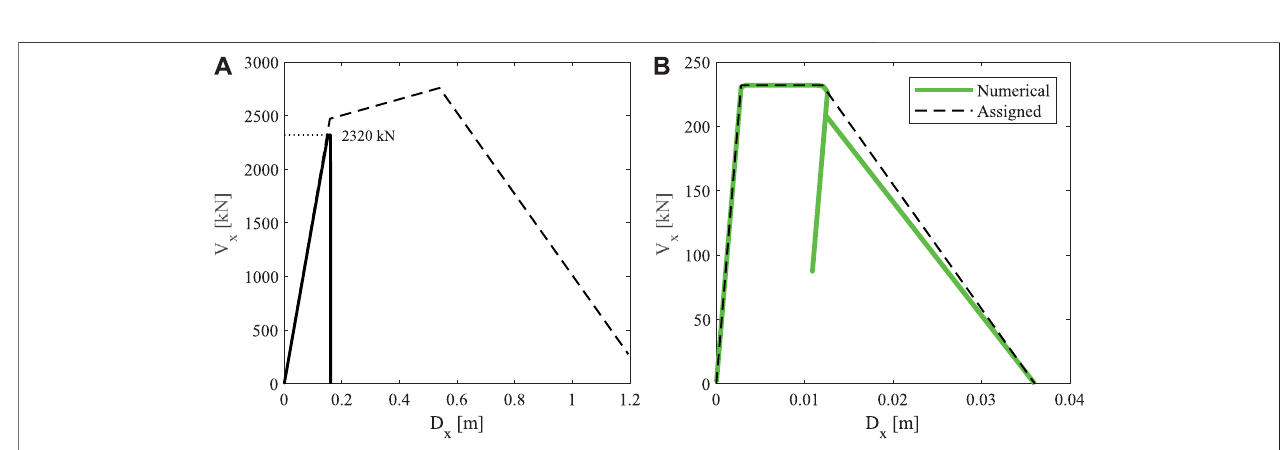
FIGURE 9 | (A) Pushover curves along X direction for both the models and (B) force-displacement curve in a single dowel connection. Results of the multistripe analyses.